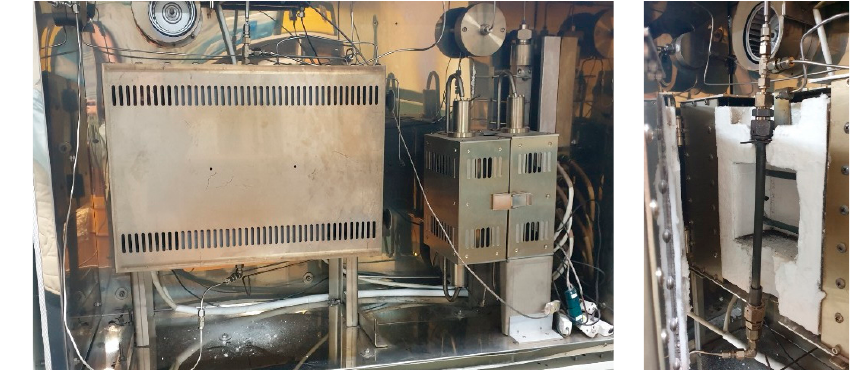
Figure 3. Flow diagram of experimental apparatus.